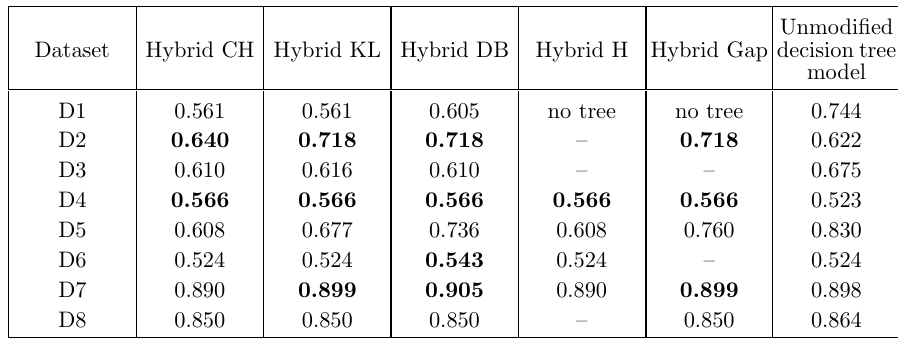
Values of G-mean